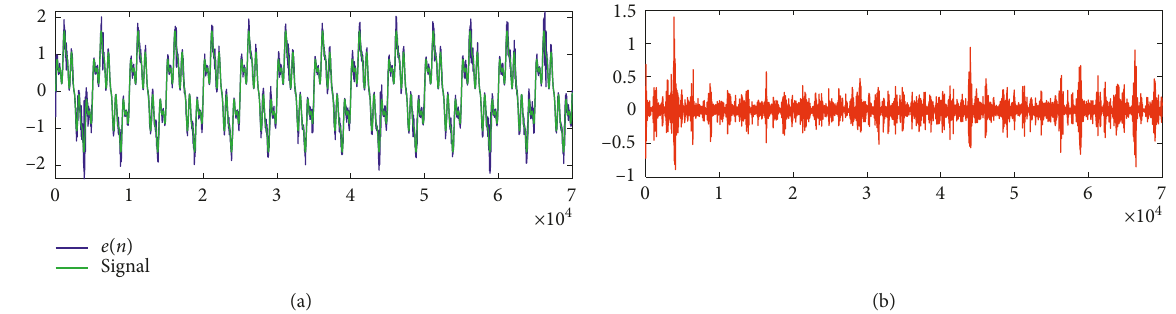
n . (b) Residual noise. ( )